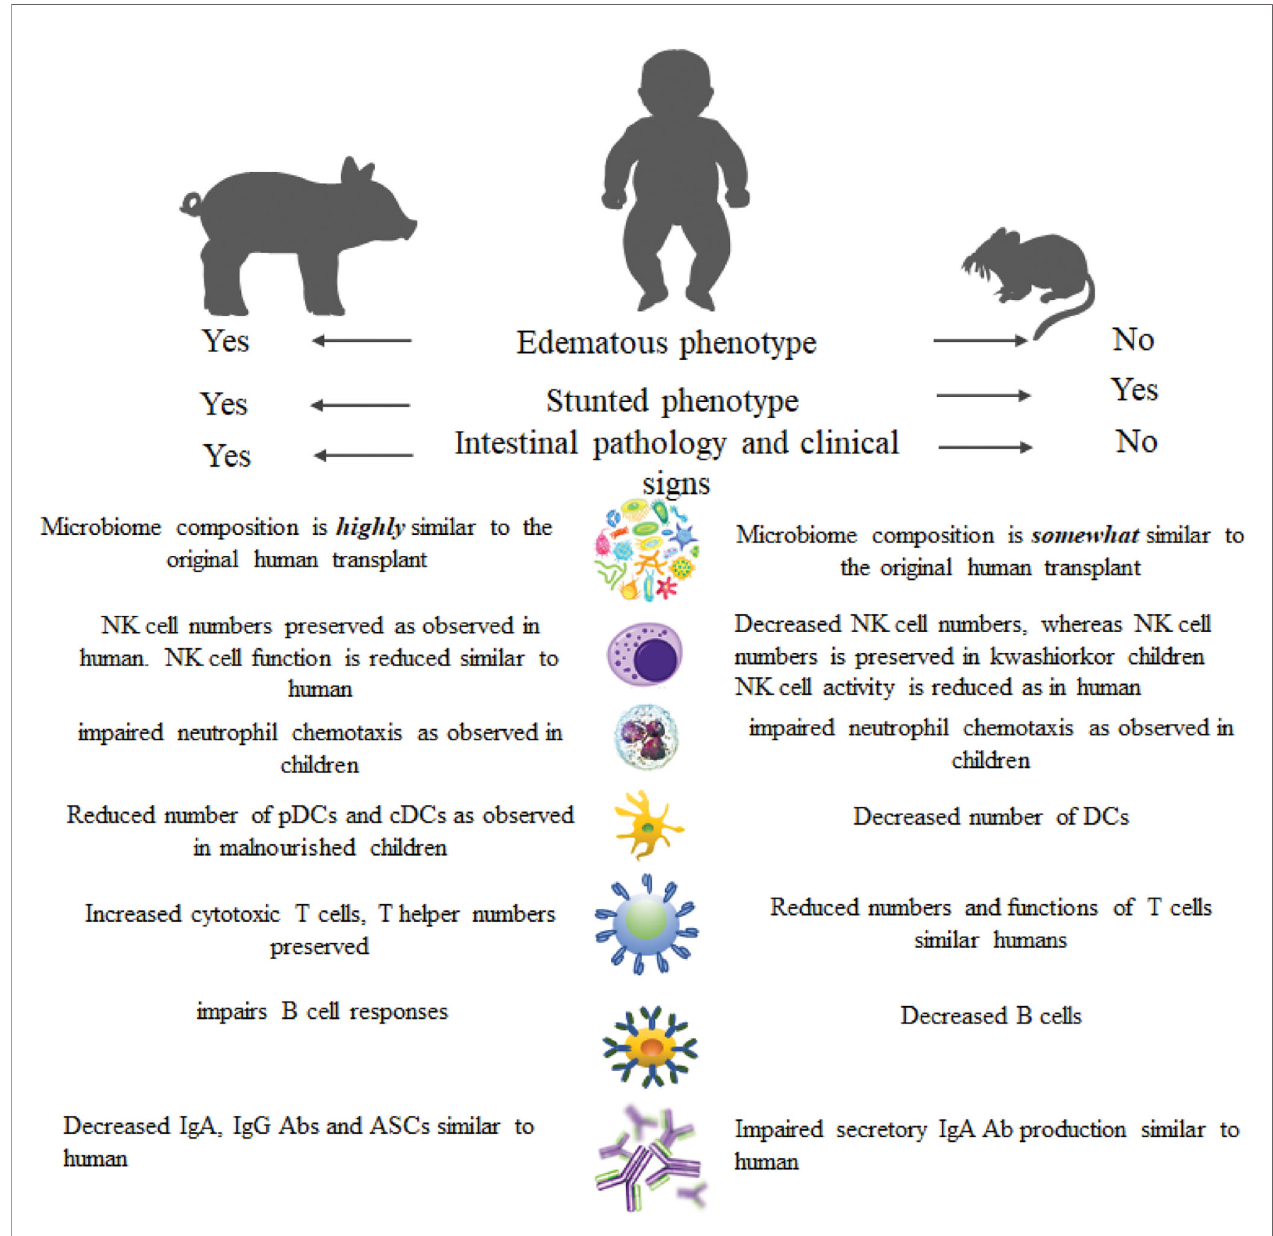
FIGURE 3 | Comparison of clinical and immune parameters of kwashiorkor in humans, pigs, and